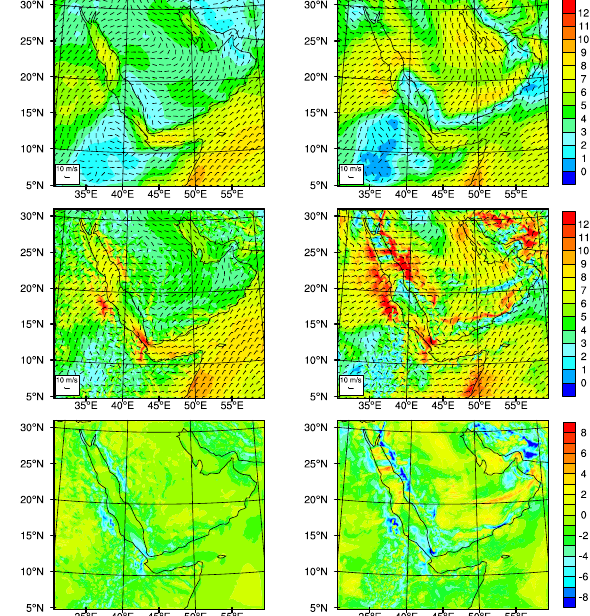
Fig. 2. ERA-Interim 10m-wind fields (upper row), modeled 10m- wind fields (middle row), the difference between ERA-Interim and modeled 10m-wind fields (lower row). Instantaneous fields (right column) at 12:00UTC on 14 January 2009 and the averaged fields (left column) are well correlated with correlation coefficient of 0.62 and 0.82,